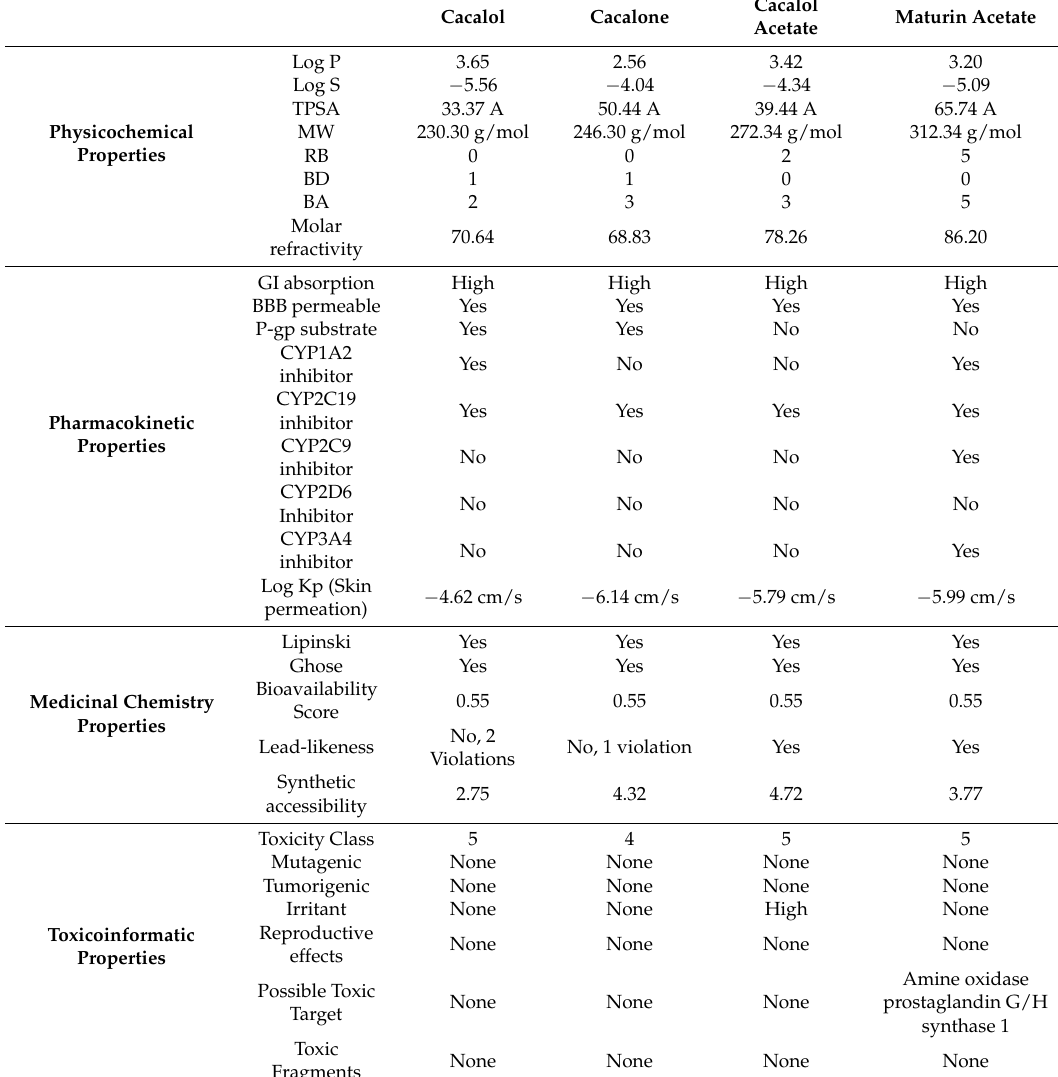
Table 1. Estimated physicochemical, pharmacokinetic, medicinal chemistry and toxicoinformatic properties of cacalolides *